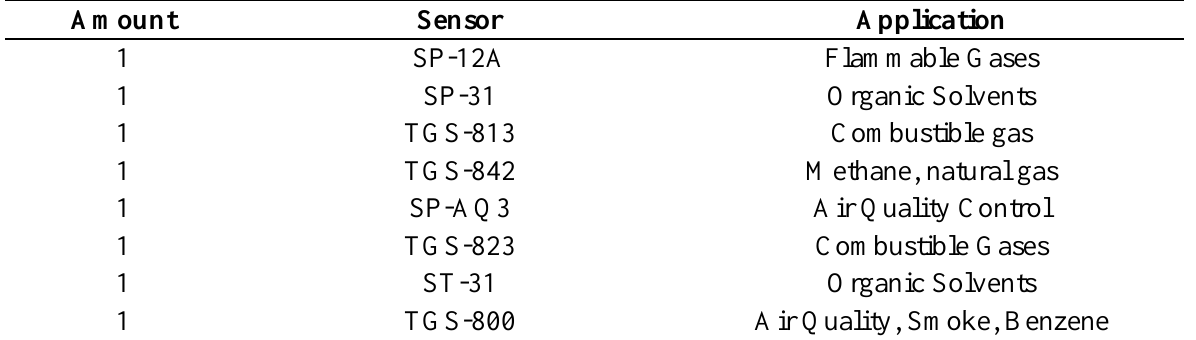
Table 1. Sensor array